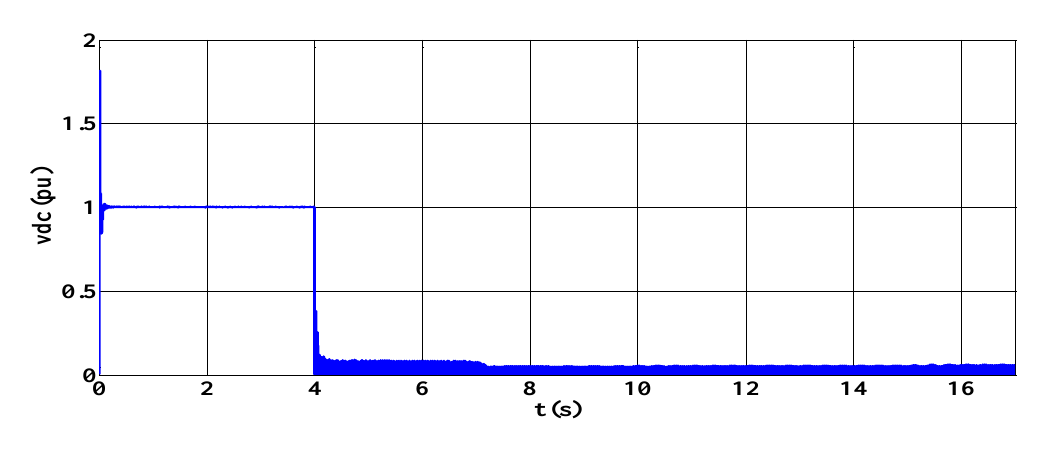
Figure 18. DC link voltage (short-circuit happens at t = 4 s).